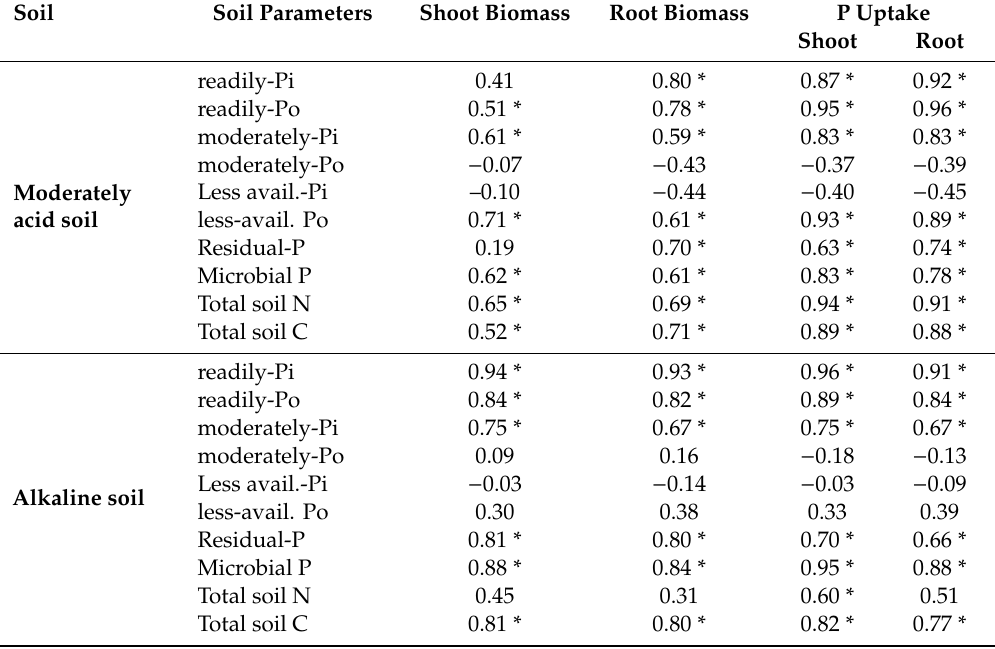
Table 5. Relationship between soil and plant parameters after 7 weeks of ryegrass growth in control and soil amended with poultry manure compost (PM), phosphate rock (RP), and their combination (PMRP). *denotes significant correlation coe ffi cients ( p ≤ 0.05), n =